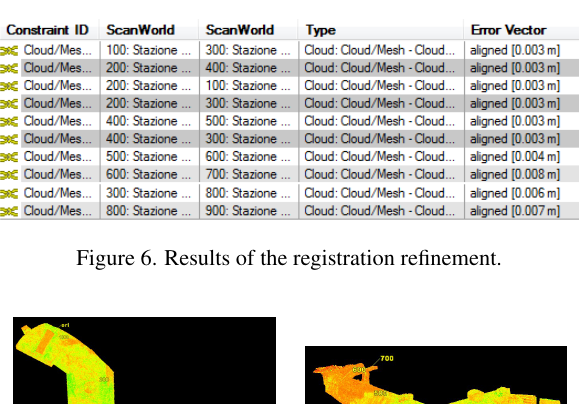
Figure 9. Error map for scale = 2.27. Figure was obtained from CloudCompare. Red values corresponds to higher error values. Values are saturated at 41cm (red values start approximately at 33cm, as shown in the color bar on the right).